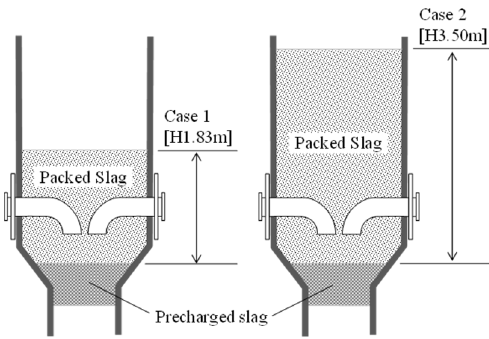
Figure 11. Level of slag packed bed in two cases of CFD simulations.